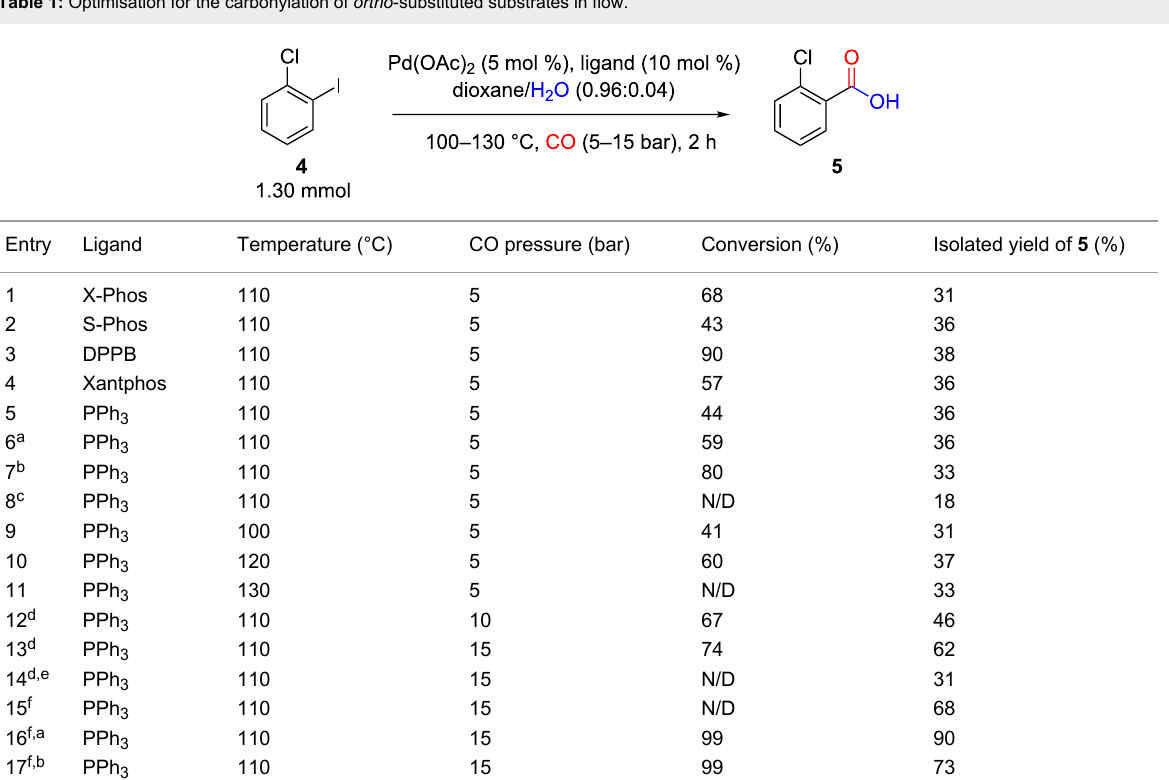
Table 1: Optimisation for the carbonylation of ortho -substituted substrates in flow.